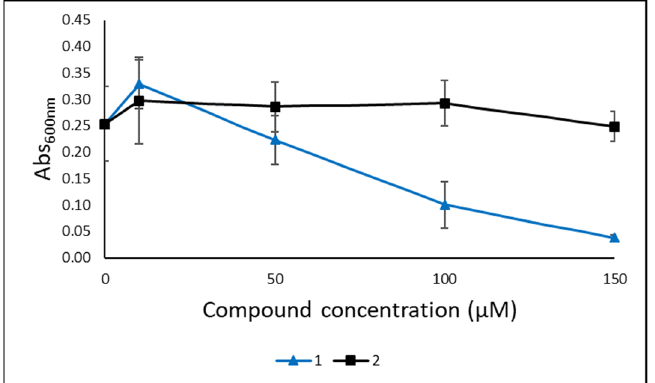
Figure 5. Antibacterial activity of 1 and 2 tested in a growth inhibition assay against the Gram- positive S. agalactiae . The assay was performed in three independent experiments, each with three technical replicates.